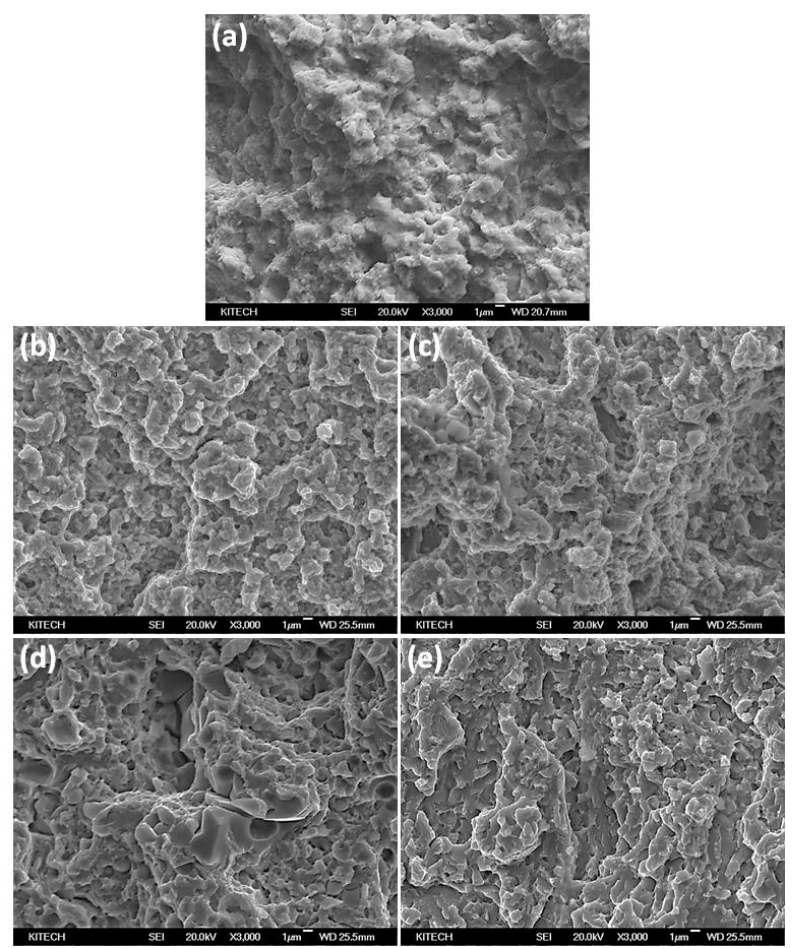
Figure 9. Micro-images of the fracture surface: ( a ) as-deposited M4; ( b ) A; ( c ) F; ( d ) AT; ( e ) FT.